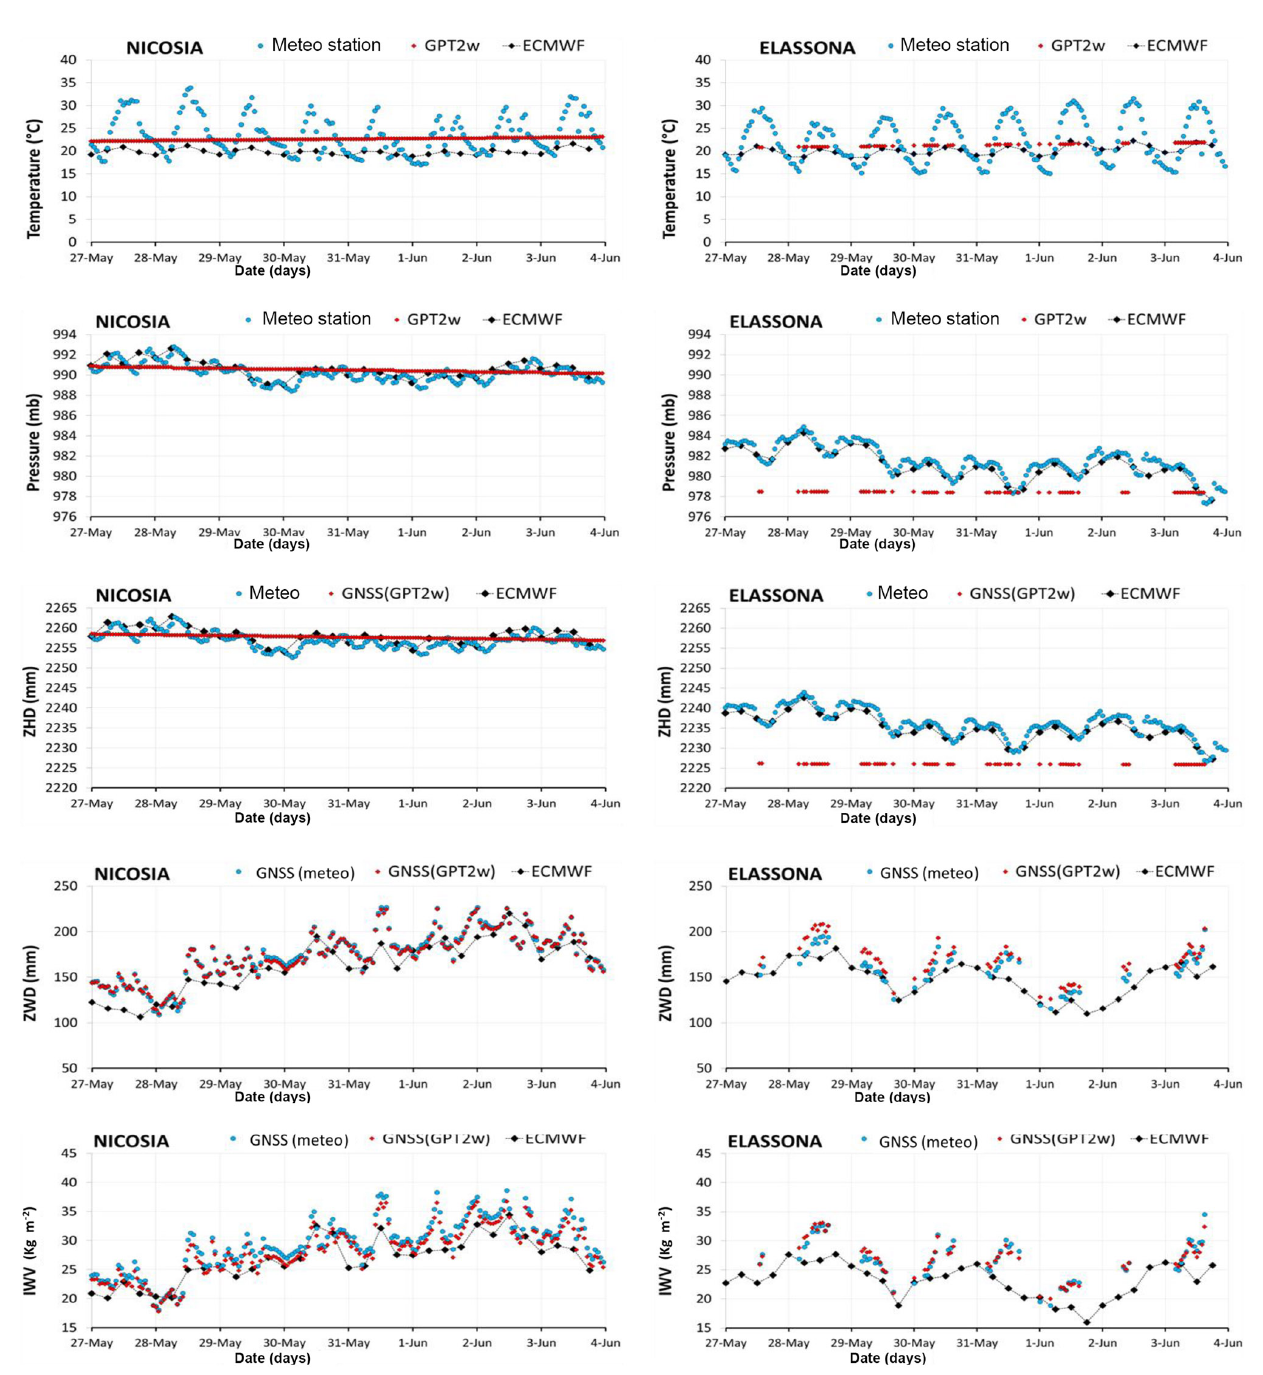
Figure 2. Variations of T , P , ZHD, ZWD, and IWV for Nicosia and Elassona stations from collocated meteorological stations (blue dots), GPT2w (red boxes) and ECMWF (black boxes) spanning the period 27 May–3 June 2018.